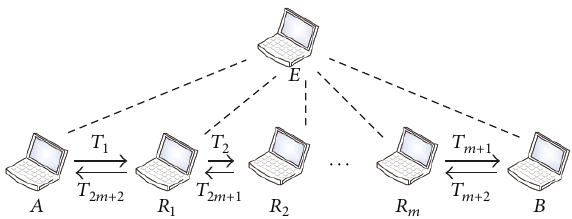
Figure 2: Illustration of one external eavesdropper in the basic